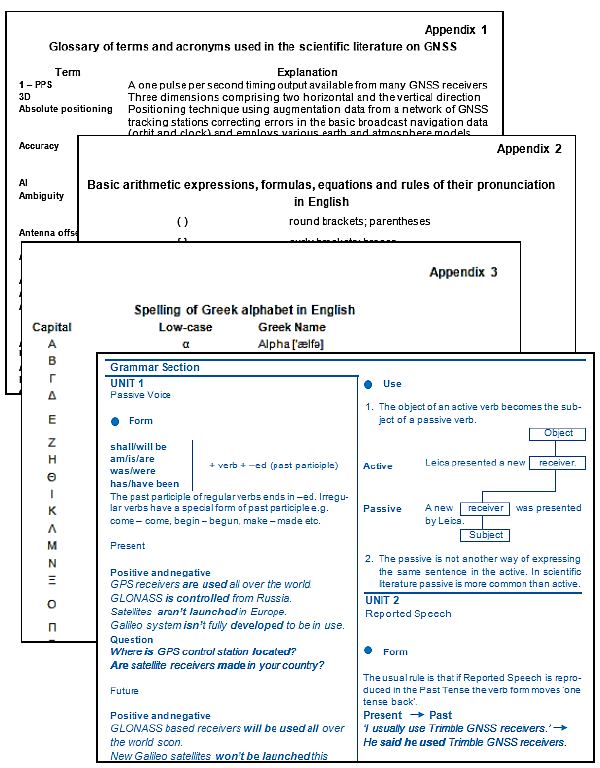
Figure 3. Appendices of the